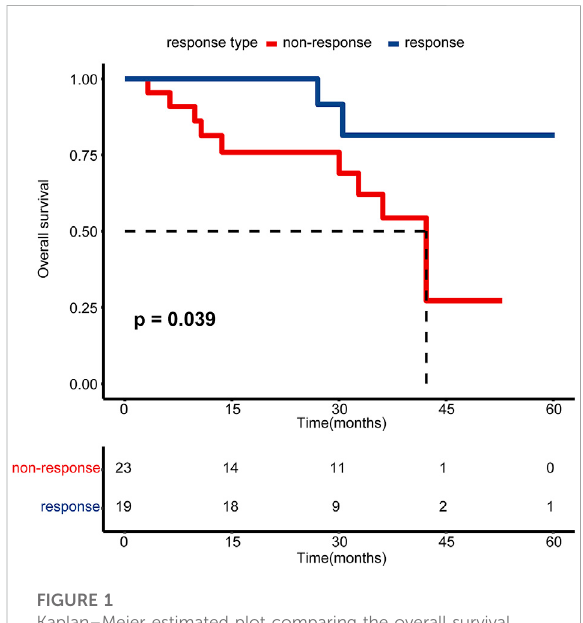
FIGURE 1 Kaplan – Meier estimated plot comparing the overall survival of patients with pathological response and non-response groups. The red line represents the non-responsive group, while the blue line represents the responsive